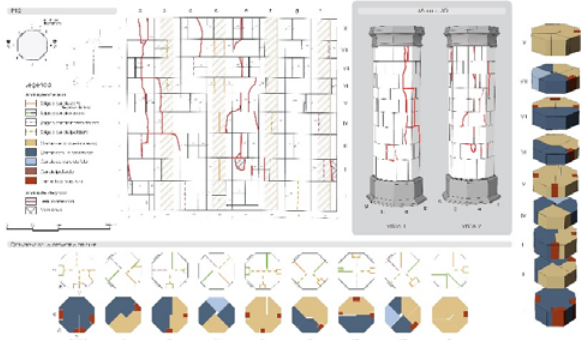
Figure 9. Pillar n. 12: drawings made during diagnostic phase.